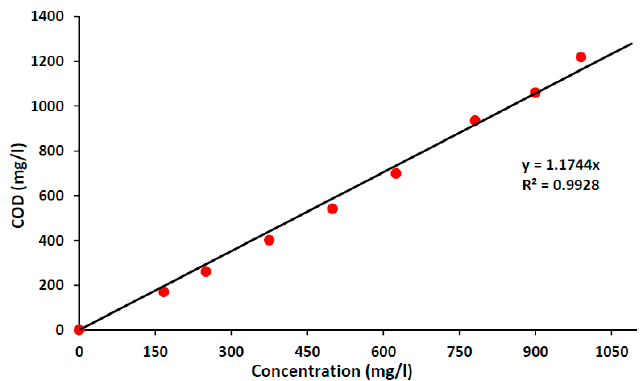
Figure 3. COD-saccharose relationship.